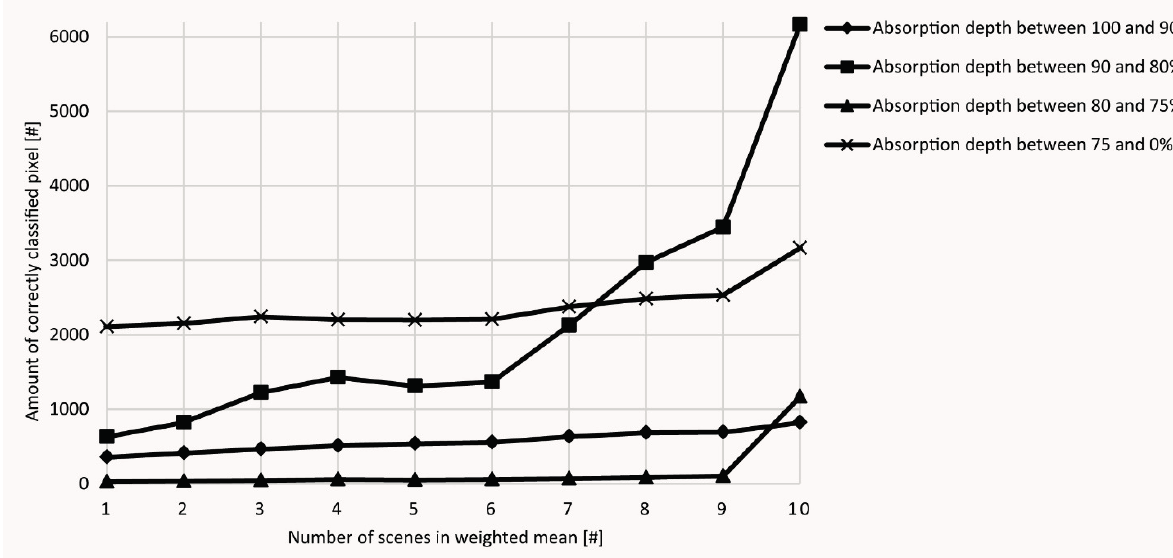
Figure 10. The impacts of using multiple image scenes for a weighted mean in the first step of the approach. Each run was performed using one more of the collected image scenes. The first run was accomplished using the image scene with the highest homogeneity for the white references. The SNR was calculated using the reference panels that were placed in front of the outcrop. Run after run, one image scene was added to the weighted mean according to its descending SNR. After using the best seven scenes, an increase in the number of correctly classified pixels was observed for the transition pixels between the enriched zones and the unenriched areas. From then on, every run that included one additional scene had a better